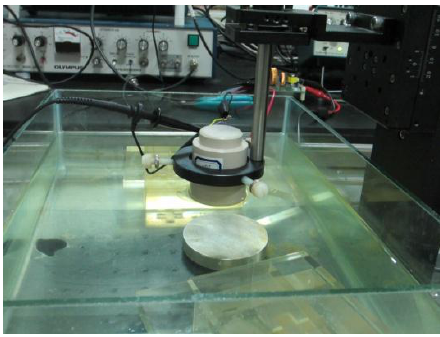
Figure 7. Impedance measurement of the transducer